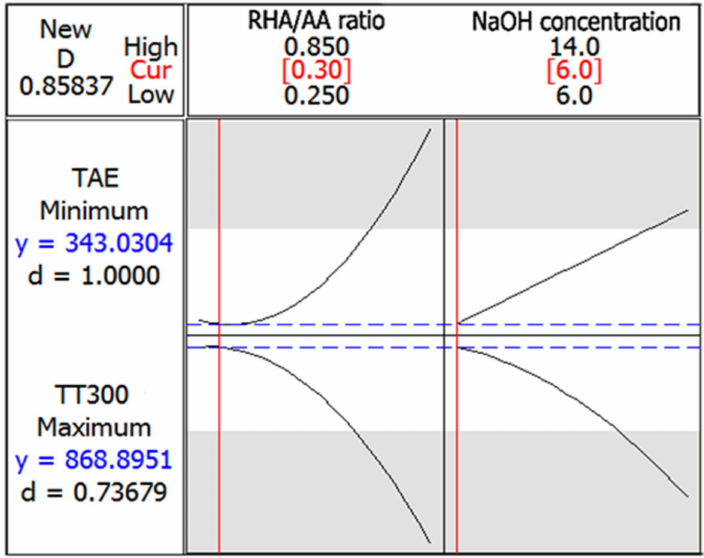
Figure 10. Optimization plot in fire-retardant test.